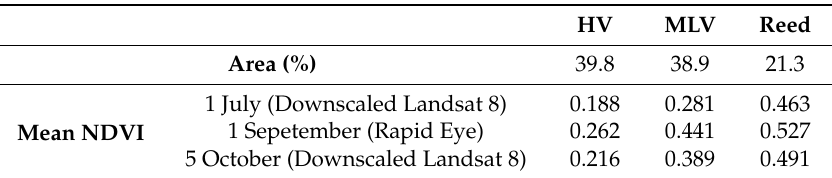
Table 10. Zonal statistics of each vegetation